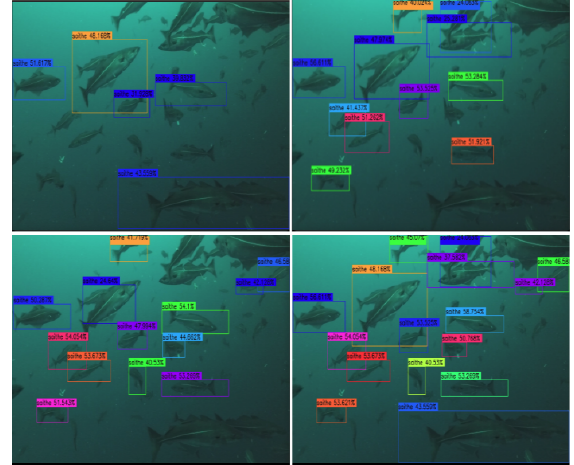
Figure 4: Performing detection in multiple input reso- lutions. The results are given for input sizes of 416 (top-left corner), 608 (top-right cor- ner), 1024 (bottom-left corner) and the com- bination of 224, 416, 608, 864, and 1504 si- multaneously, applying non-maximum sup- pression to delete repeated boxes (bottom- right corner).